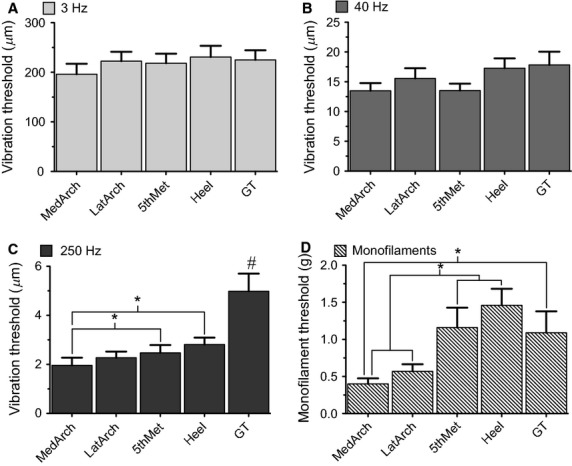
Mean vibration and monofilament perception thresholds across the foot sole with standard error. No significant differences were found across site at 3 Hz (A) or 40 Hz (B) VPT. Significant differences were found at 250 Hz VPT (C) and MF (D). # indicates a significantly higher threshold of the GT compared to all other sites and * denotes a significant difference (P < 0.05).